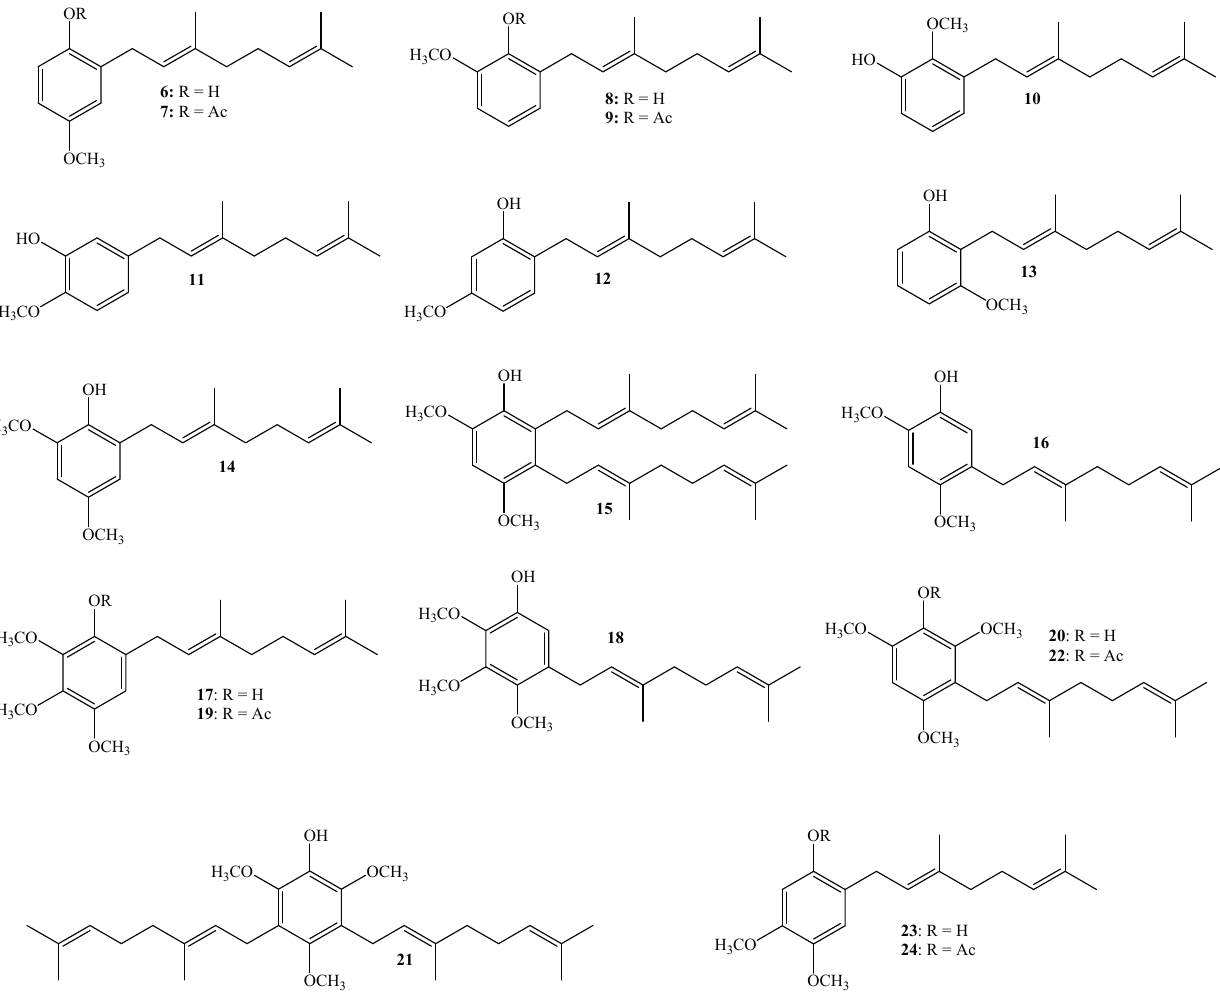
Figure 2. Structures of linear geranylphenols 6 – 24 tested in this